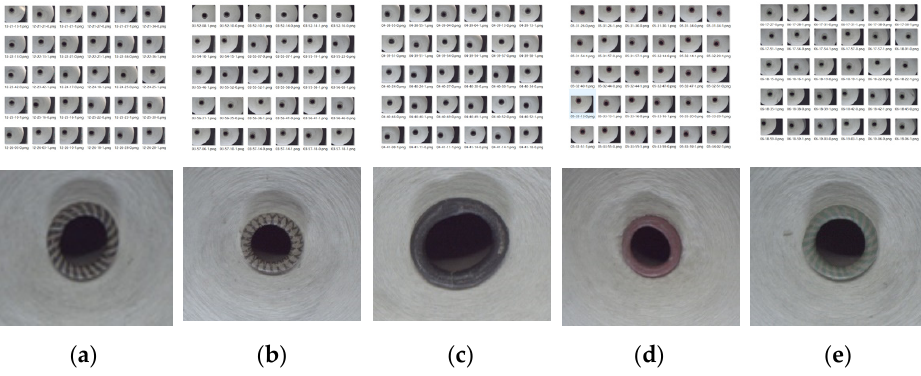
Figure 2. Cone yarn samples: ( a ) cone yarn with black twill bobbin; ( b ) cone yarn with black fork bobbin; ( c ) cone yarn with the pure black bobbin; ( d ) cone yarn with the rose red bobbin; ( e ) cone yarn with green twill bobbin.